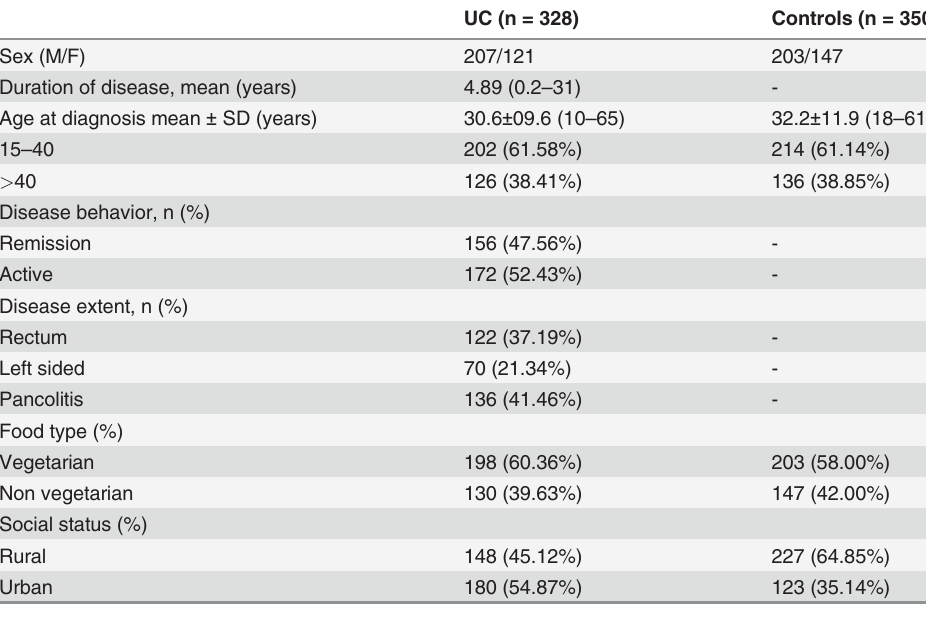
Table 1. Demographic and clinical features of UC and